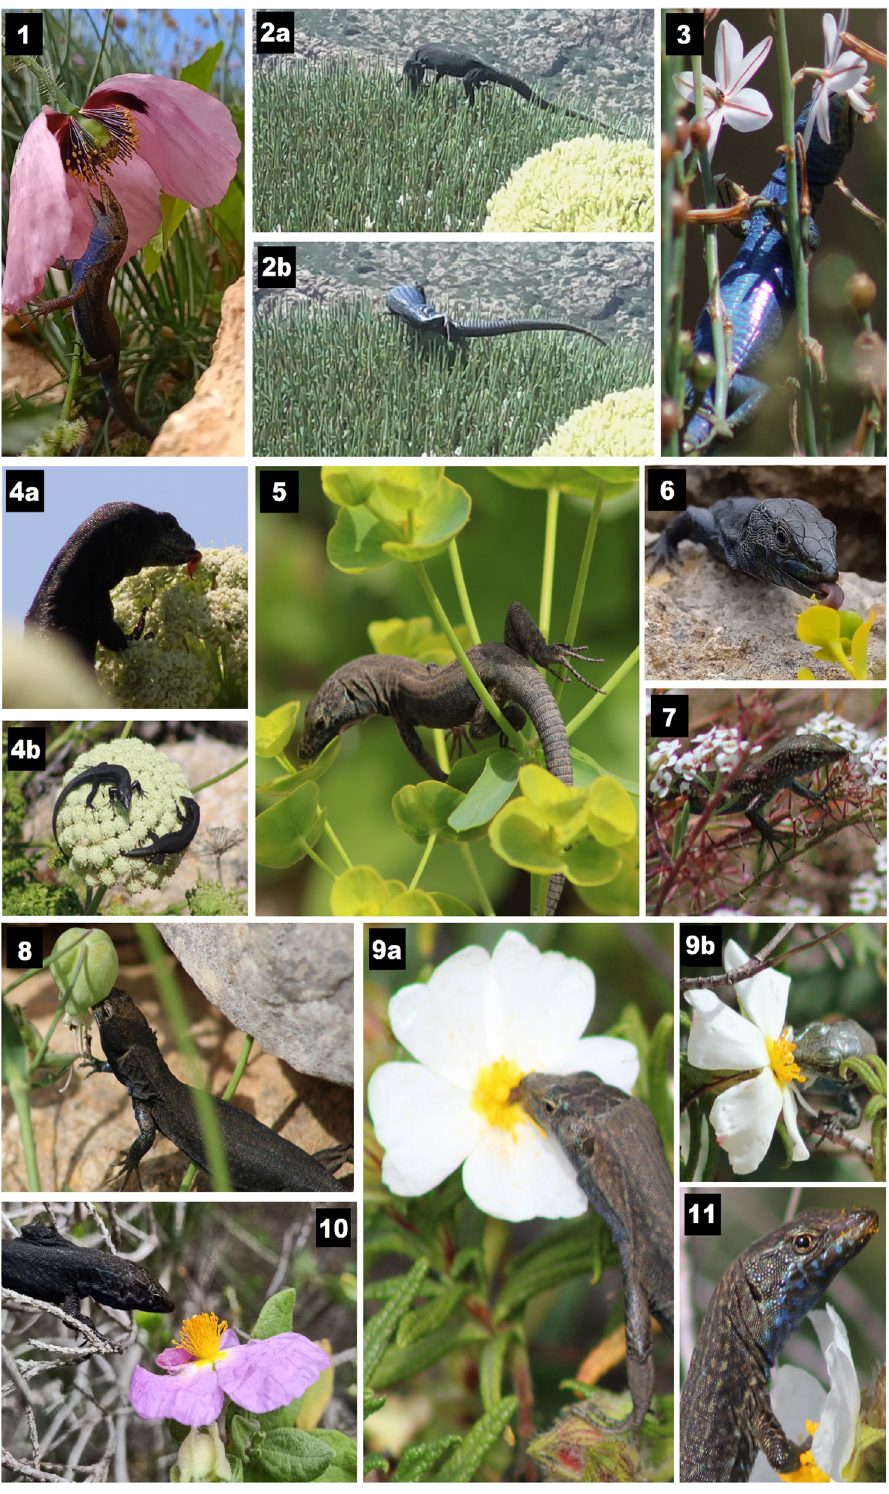
Figure 1. Lizard–flower interactions observed on Cabrera Gran: florivory in Papaver somniferum ( 1 ), Astragalus balearicus ( 2 ) and Asphodelus fistulosus ( 3 ); legitimate visits in Daucus carota ( 4 ), Euphorbia segetalis ( 5 ), Euphorbia dendroides ( 6 ), Lobularia maritima ( 7 ), Silene vulgaris ( 8 ), Cistus monspeliensis ( 9 ) and Cistus heterophyllus ( 10 ); and pollen grains visible over a lizard ( 11 ).